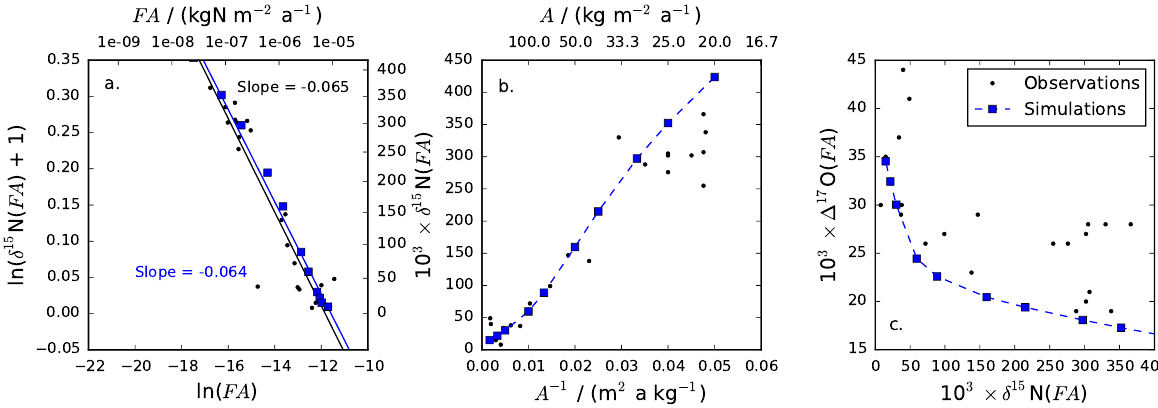
Figure 8. Realistic simulation with varying snow accumulation rates (blue squares) versus observations along the D10–Dome C–Vostok route (black dots). (a) Modified Rayleigh plot. The two lines are linear fit to the data and the slopes are given in the respective colors. (b) δ 15 N(FA) versus the inverse of the snow accumulation rates. (c) (cid:49) 17 O(FA) versus δ 15